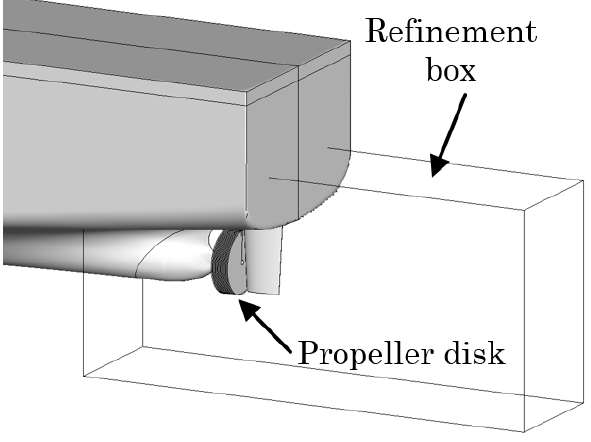
Figure 6. Propeller disk for behind hull condition [41].